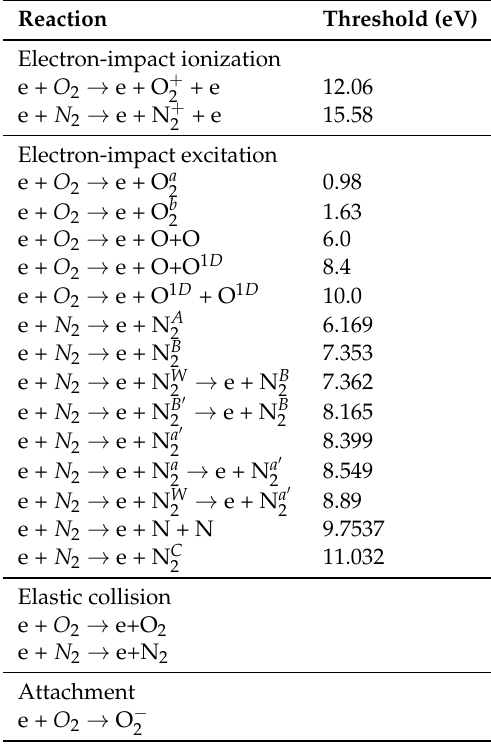
Table 1. Electron-impact ionization, electron-impact excitation, elastic collision, and attachment reactions between species. The threshold energies data and cross sections are sourced from Ref. [53] and the LXCat database